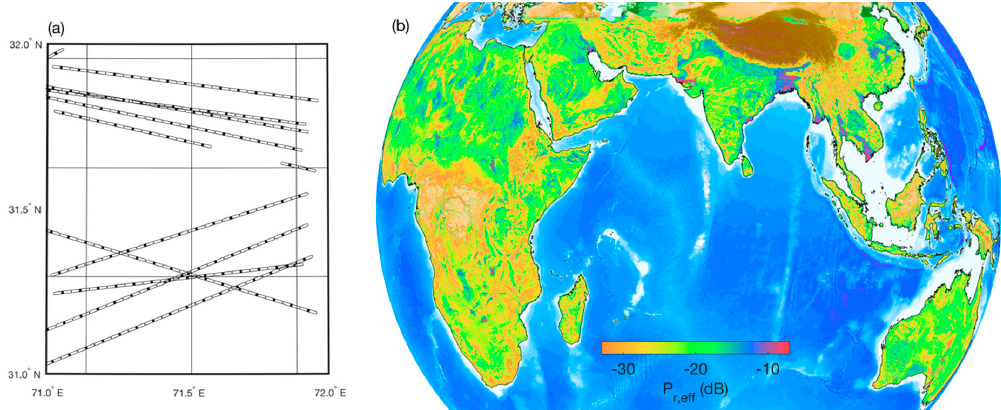
Figure 2. ( a ) Illustration of the pseudo-random surface sampling by CYGNSS (ellipses with dots). Ellipses are approximately 7 × 0.5 km in size, which is the expected footprint if the surface has little surface or topographic roughness. Dots are the location of the specular reflection points recorded by CYGNSS. This example shows coverage for one typical 24-hr period. Grid cells are the size of the EASE2 36-km grid cells. ( b ) Over time, observations made by CYGNSS completely cover the land surface, producing maps such as this (CYGNSS observations overlaid on DEM). Here, higher values could indicate a wet surface or a relatively flat surface.